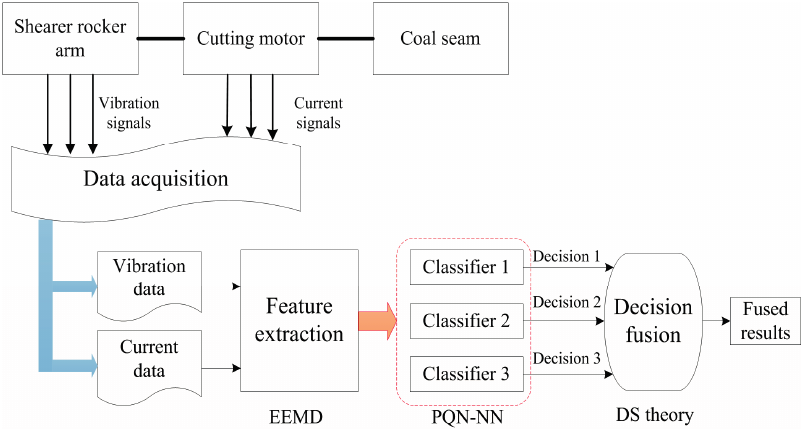
Figure 1. Flowchart of the proposed condition identification system for shearer drum.